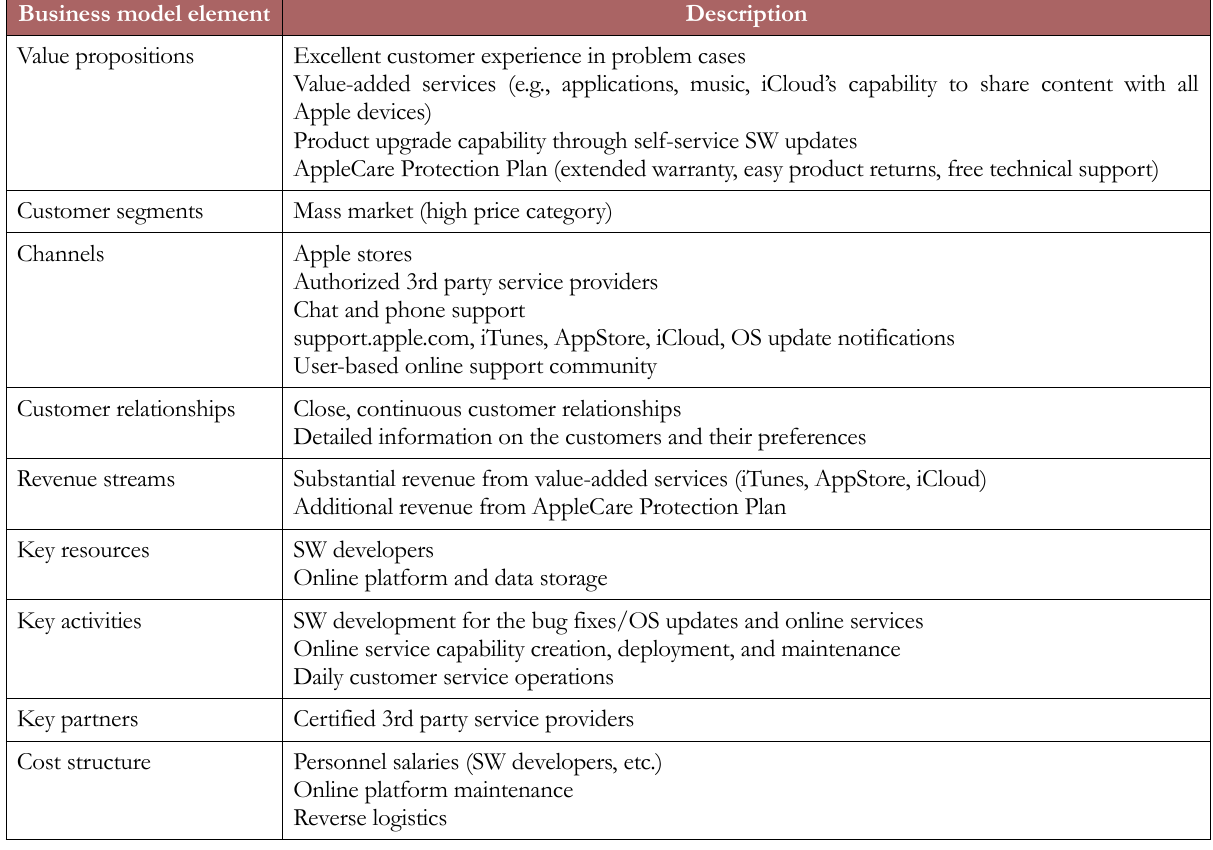
Table 2. The analysis of Apple iPhone’s customer care business model based on the framework by Osterwalder and Pigneur